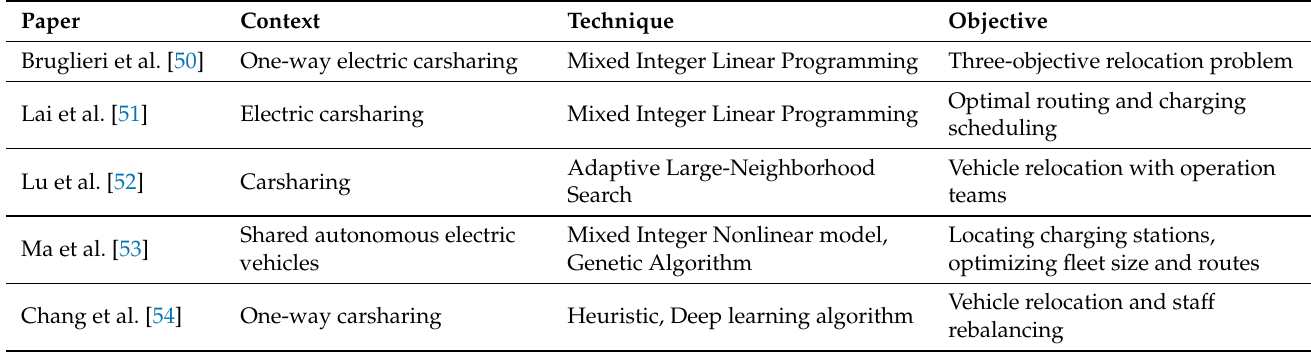
Table 2. Main targeted objectives in the reviewed carsharing papers.